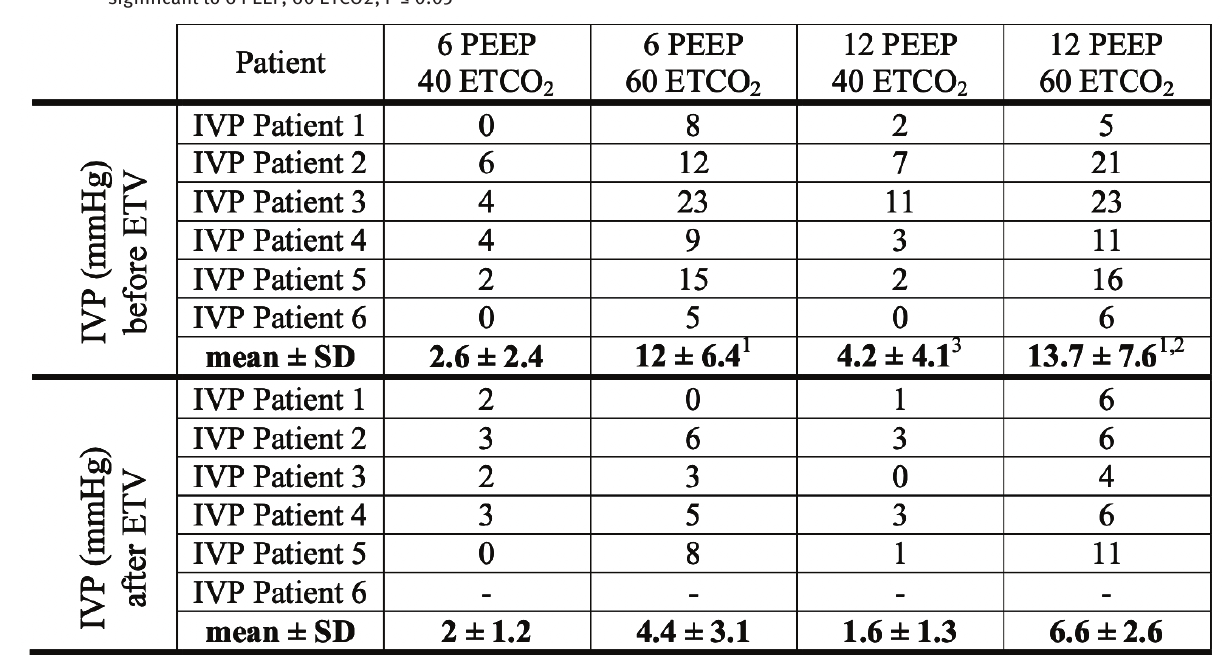
Table 1: Summarizes intraventricular pressure (IVP, mmHg) recordings at 6 cm (6 PEEP) and 12 cm H2O (12 PEEP) positive end-expiratory pressure (PEEP) during normocapnia (40 ETCO2) and hypercapnia (60 ETCO2) before and after endoscopic third ventriculostomy (ETV) in six